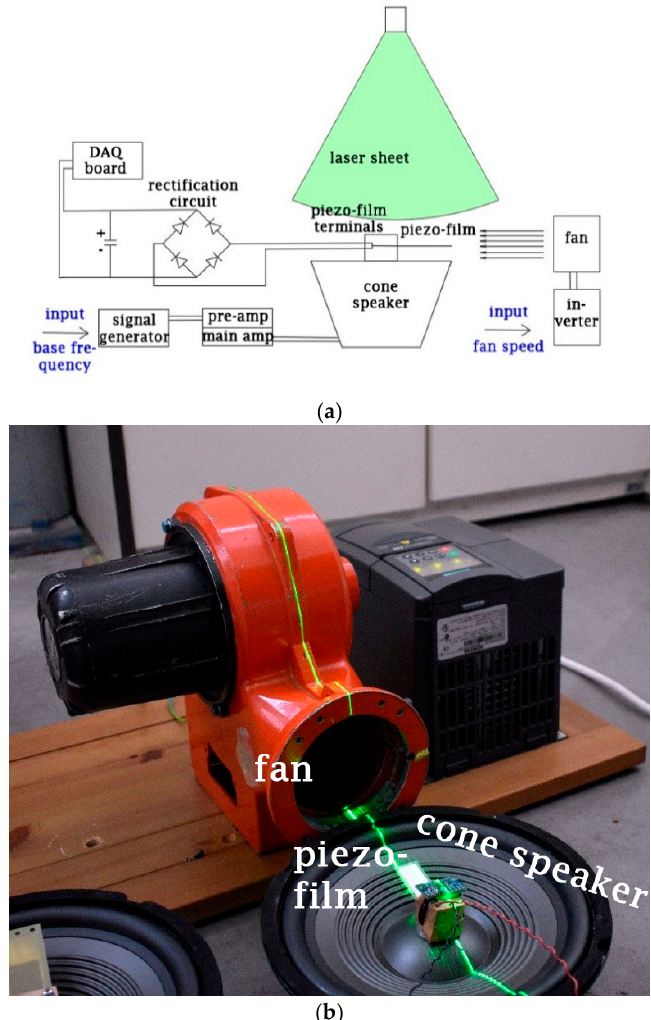
Figure 5. ( a ) Schematic representation of the experimental setup; ( b ) detail of the setup showing the relative position of the fan with respect to the piezo film and the laser beam position. The piezo film was mounted on the dust cap of the cone speaker. Table 3. Test matrix with all the combinations of base excitation frequency (horizontal direction) with aerodynamic exci- tation (fan speed in the vertical direction). The specific symbols denote: ◊ capacitor voltage measurements, □ laser projec- tion measurements, O mean flow velocity measurements.